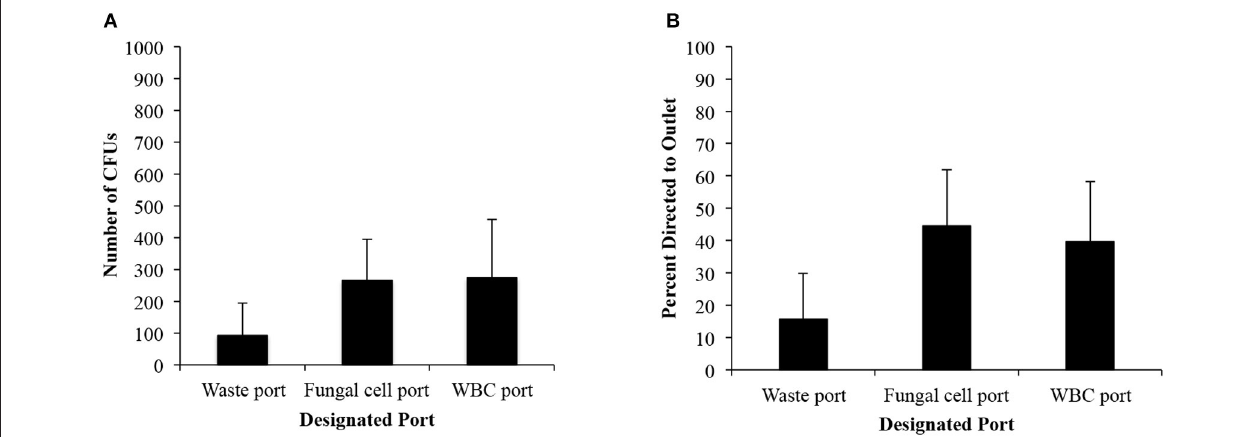
FIGURE 3 | IFF data for C . albicans in lysed blood. (A) Distribution of the raw number of CFUs. (B) Percent distribution of C . albicans CFU between each port from cells spiked in whole blood from a starting concentration of cells was 8,000 cells per 5mL sample. Error bars indicated standard